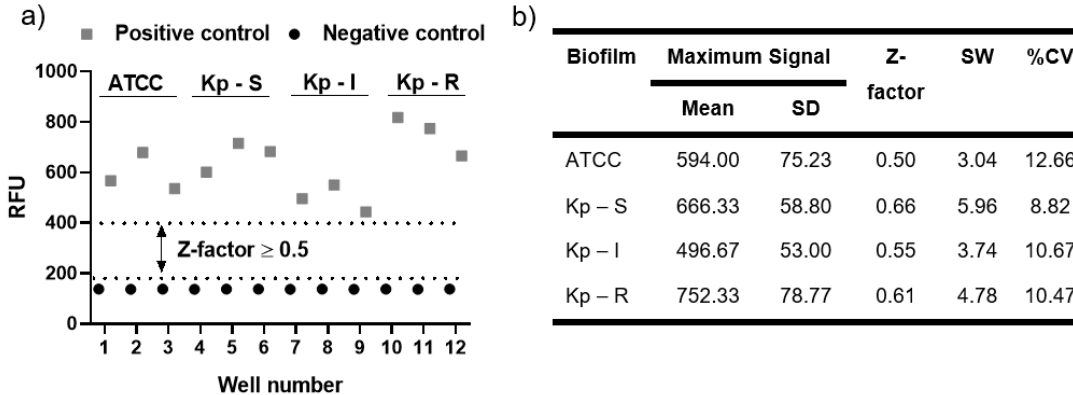
Figure 5. Indicator of assay quality of biofilm formation of K. pneumoniae . ( a ) Distribution chart of the positive and negative controls of the studied biofilms and the Z-factor presentation; ( b ) Mean and SD in RFU of the positive control biofilms, with the determination of the Z-factor, signal window (SW), and percent coefficient of variation (%CV). The negative control had a mean of 137.67 RFU with an SD of 0.58 RFU.